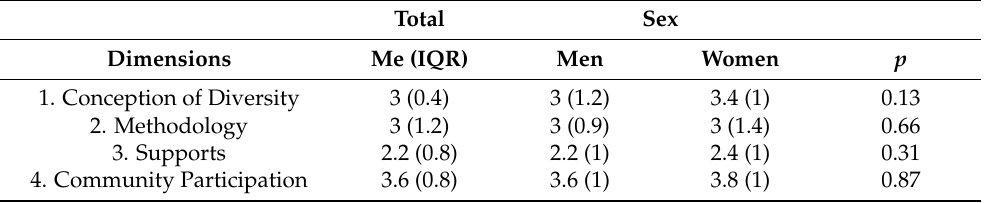
Table 4. CEFI-R descriptive analysis and differences of each dimension, searching for differences between sex and educational stage.